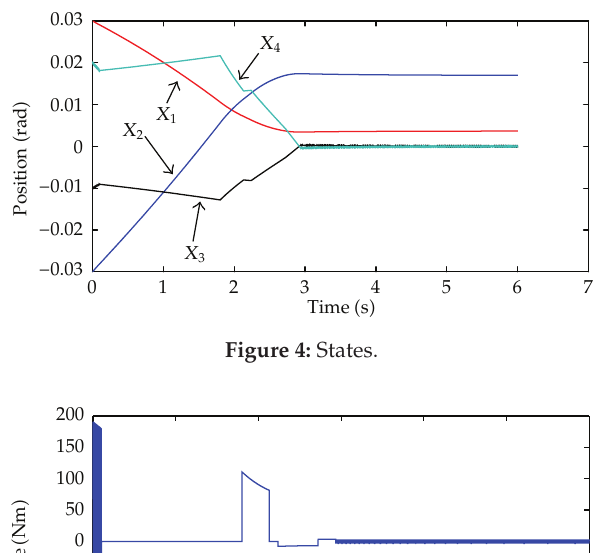
Figure 3: Mode jumping.